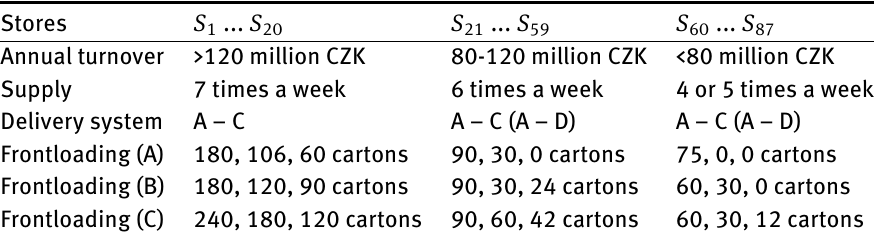
Table 1: Comparison of the stores in the food supply